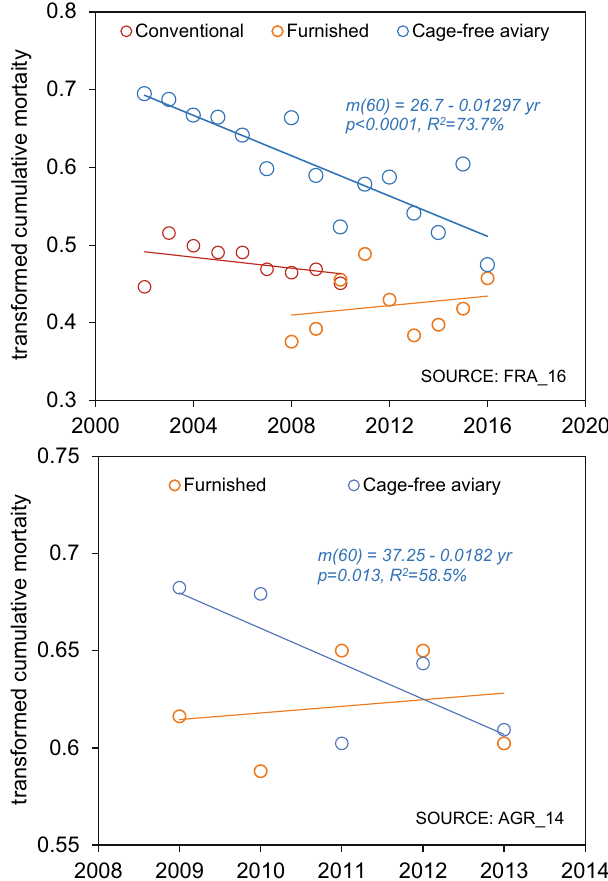
Figure 5. Time series of cumulative layer mortality for two independent data sources. Regression of cumulative mortality rate (m60, double arcsine transformed) as a function of year of data collection for commercial flocks raised in conventional cages, furnished cages and a non-cage system (single-tier aviaries) in France (source code FRA_16) and the Netherlands (AGR_14). Regression equations are shown where the effect of year is significant.